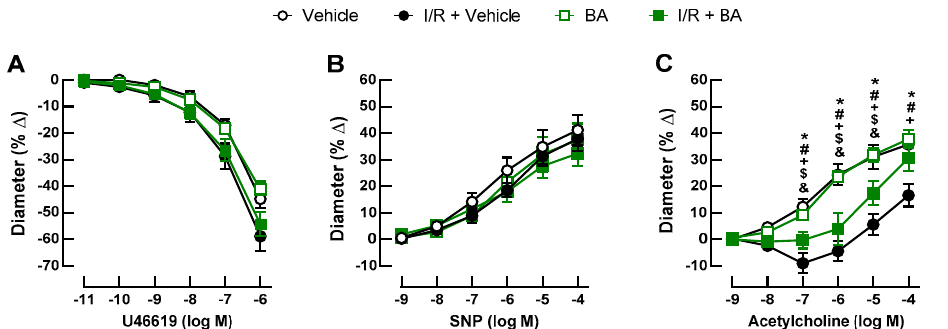
Figure 2. Responses of retinal arterioles to vasoactive substances. ( A ) The thromboxane mimetic, U46619, elicited concentration-dependent vasoconstriction in retinal arterioles that was similar in all groups. ( B ) Likewise, responses to the endothelium-independent vasodilator, sodium nitroprusside (SNP), did not differ between the four groups. ( C ) In contrast, retinal arterioles from mice subjected to I/R displayed blunted endothelium-dependent vasodilator responses to acetylcholine, which were partially improved by treatment with BA. Values are expressed as the mean ± SE (* p < 0.05, I/R + vehicle versus vehicle; # p < 0.05, I/R + vehicle versus BA; + p < 0.05, I/R + vehicle versus I/R + BA; $ p < 0.05, I/R + BA versus vehicle; & p < 0.05, I/R + BA versus BA; n = 8 per group).